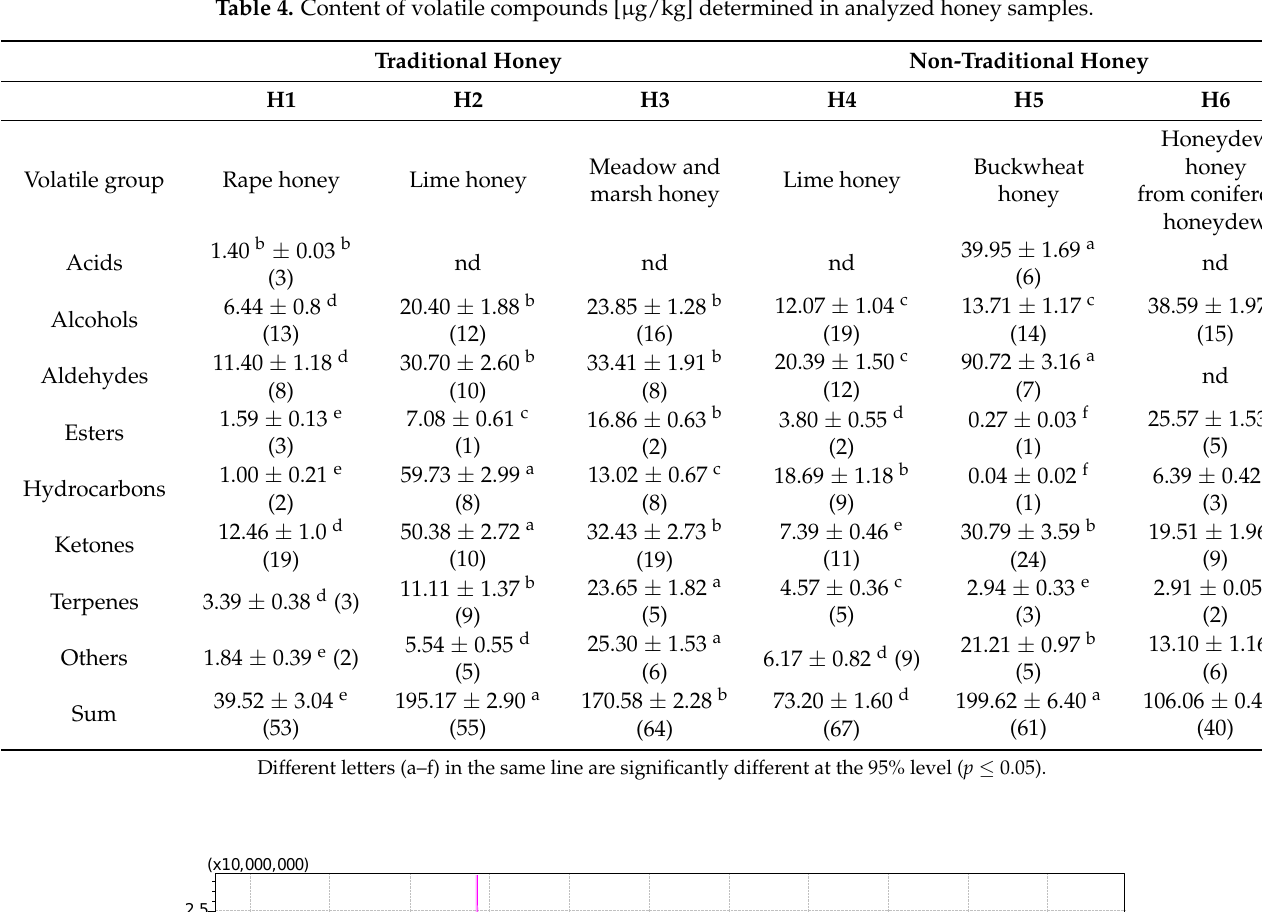
Figure 2. Chromatograms of non-traditional honey aroma compounds (black line — lime honey, pink line — buckwheat honey, blue line — honeydew honey from coniferous honeydew) . In products that were not registered as traditional products, one of the most significant groups of chemical compounds was aldehydes, which represented 27.8% of all volatile content in product H4 (non-traditional lime honey), and 45.4% in product H5. In the above-mentioned products, hydrocarbons, and acids were also found in high concentrations, which represented 25.5% and 20.0% of all volatiles, respectively. In the aroma profile of honeydew honey from coniferous honeydew, the most abundant groups of chemical compounds were alcohols and ester and their concentration represented 36.4% and 24.0% of all volatiles found in this honey. 4. Discussion 4.1. Physicochemical Analysis and Detemination of Color The moisture content of honey is influenced by the climatic condition, degree of ma- turity and extraction and storage conditions [3]. Lower moisture content can lead to the development of caramelization and the production of Maillard reaction products during honey storage at room temperature; on the other hand, higher water content might cause honey fermentation and formation of acetic acid [13]. Viscosity, solubility, crystallization, taste and color are parameters that depend on the water content of the honey [14]. The moisture content of honey samples analyzed were all within the standard limit required by the European Union’s Council Directive 2001/110/EC relating to honey whereby the moisture content, in general, should not be more than 20% [12]. The obtained results are close to those previously reported by Popek et al. [15]. Electrical conductivity is a property of electron mobility and is largely correlated with honey mineral salt, organic acids, and protein levels [16]. EC is a good criterion of the botanical origin of the honey and it is determined in routine honey control instead of the